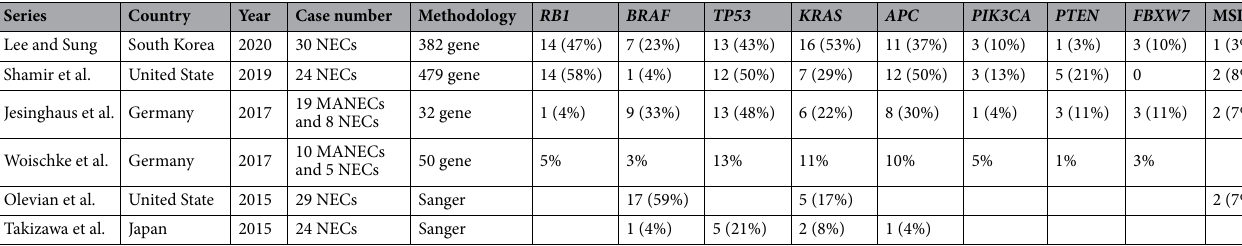
Table 4. Comparison of frequently identified mutated oncogenic genes in previous literatures and current study. Sanger Sanger